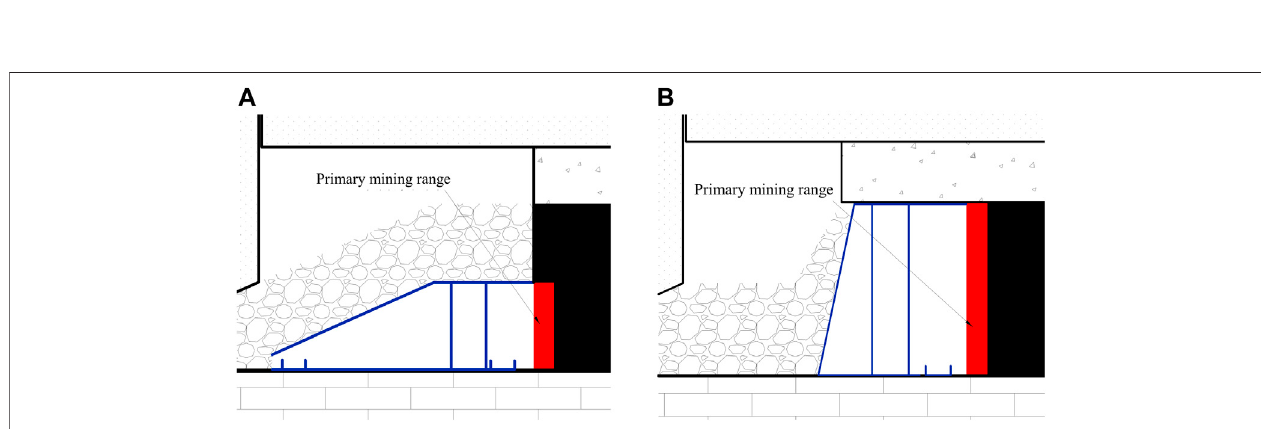
FIGURE 4 | Comparison of primary mining range of coal seam. (A) top coal caving mining. (B) full height mining at one time.